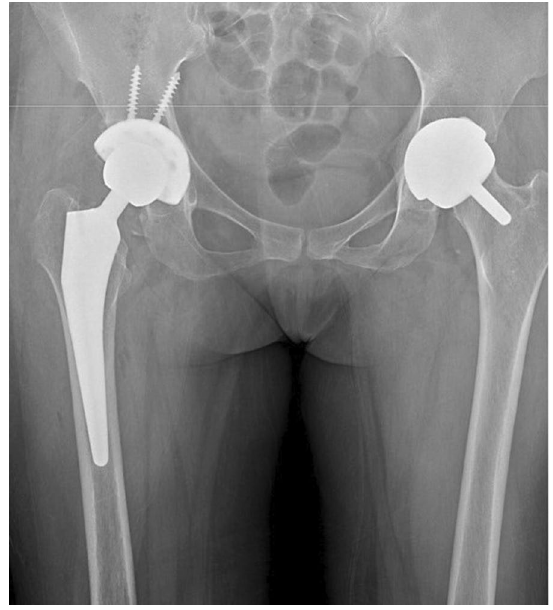
Fig. 3 Radiographs obtained during the last follow-up after six months of having the second-stage revision THA, showing good positioning and stable